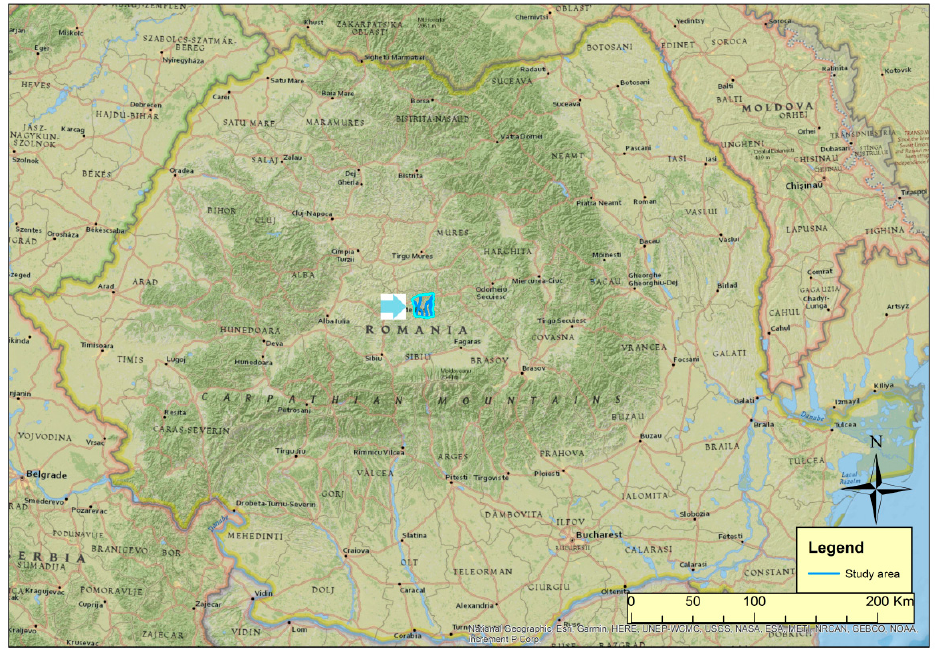
Figure 1. The study area location on the South-Eastern Carpathians basin (Romania).